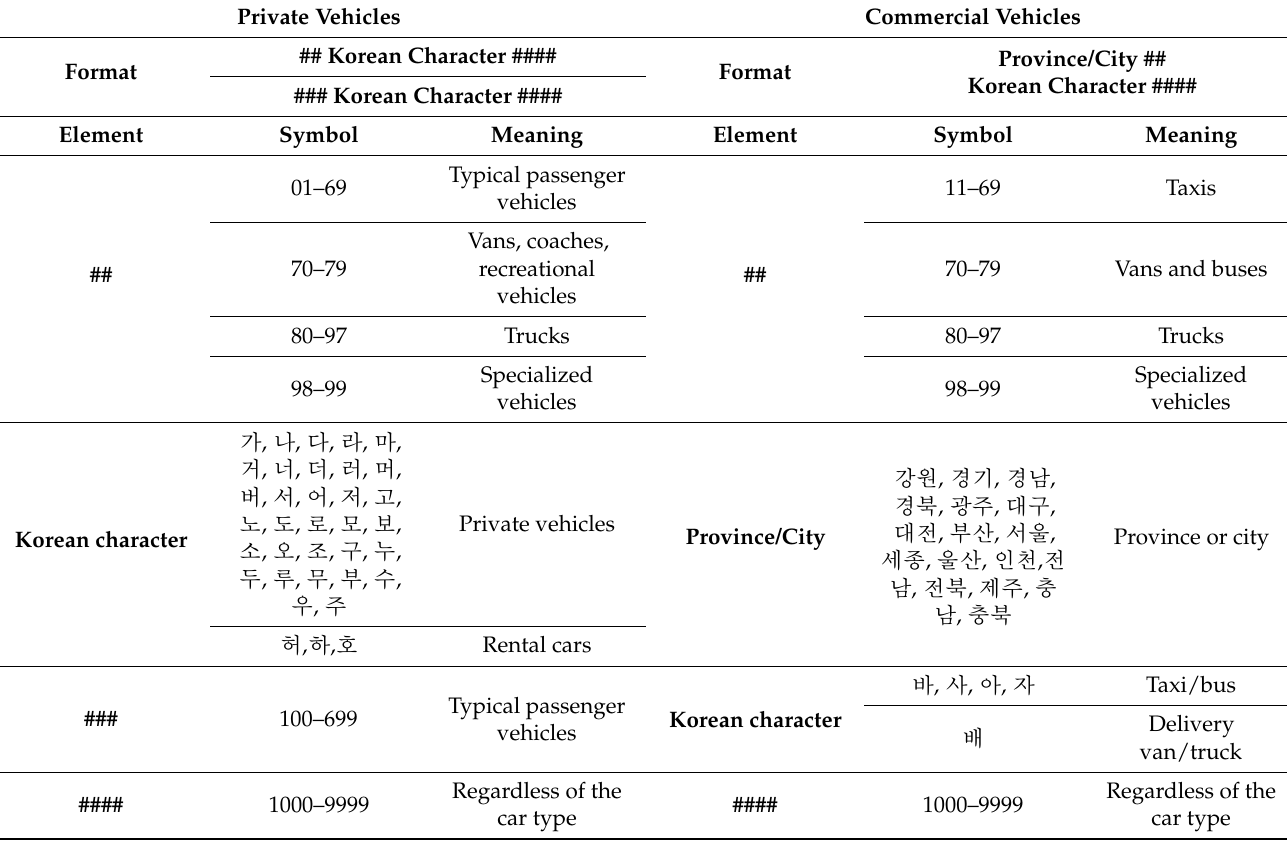
Table 1. Detailed information of license plate format in South Korea (# stands for a